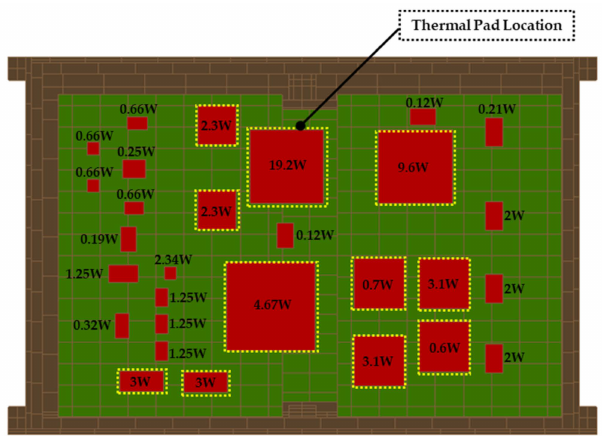
Figure 6. DRX internal configuration with heat dissipation and thermal pad location.